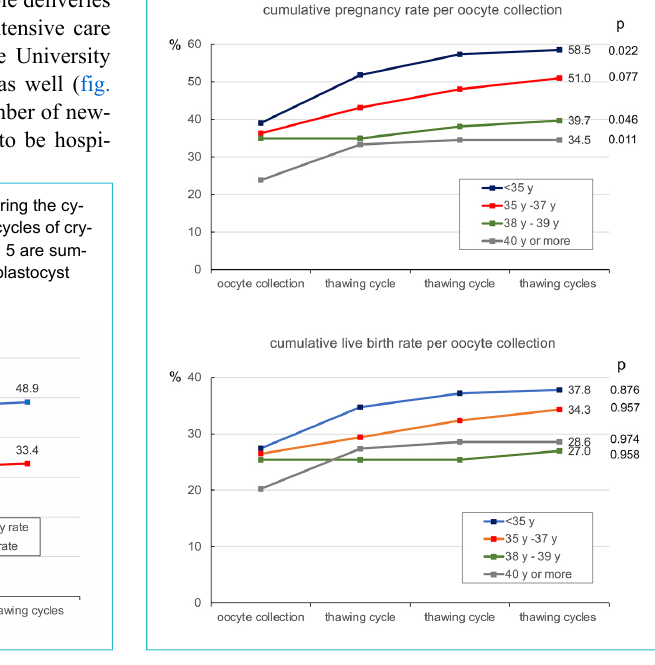
Figure 3: The cumulative pregnancy and live-birth rates are de- picted according to various age groups at the moment of oocyte collection. Due to low numbers cycle 4 and 5 are summarised as “thawing cycles”. Only one embryo in the blastocyst stage was transferred in all treatment cycles.